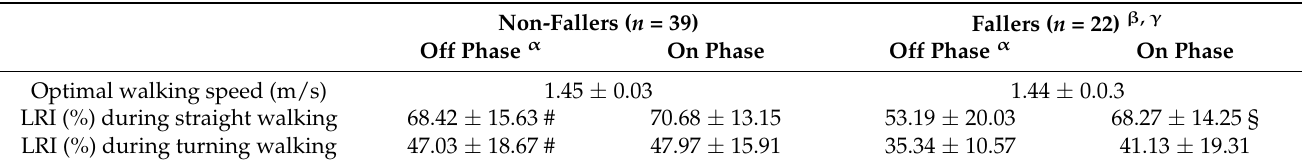
Table 4. Comparison of locomotor rehabilitation index between non-fallers and fallers before and after dopaminergic